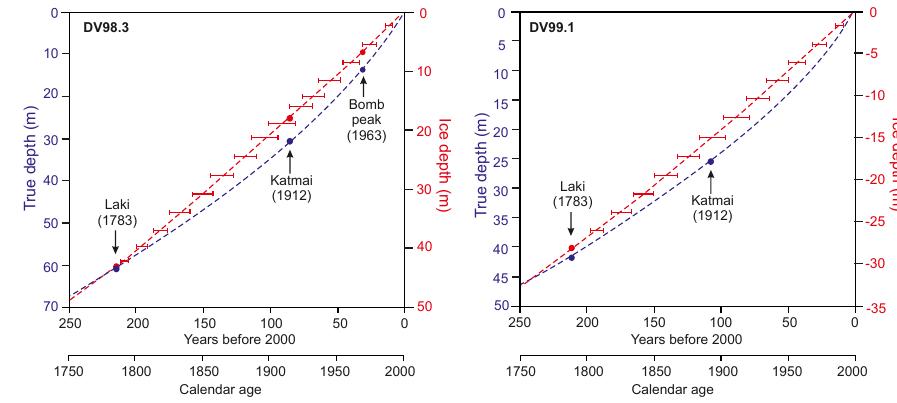
Figure 2. Age models for parts of the DV98.3 and DV99.1 cores from Devon ice cap. The error bars on the age curve relative to ice-equivalent depths (red) bracket the 95% confidence interval on the estimated age for discrete depths, as established from Monte Carlo simulations (see